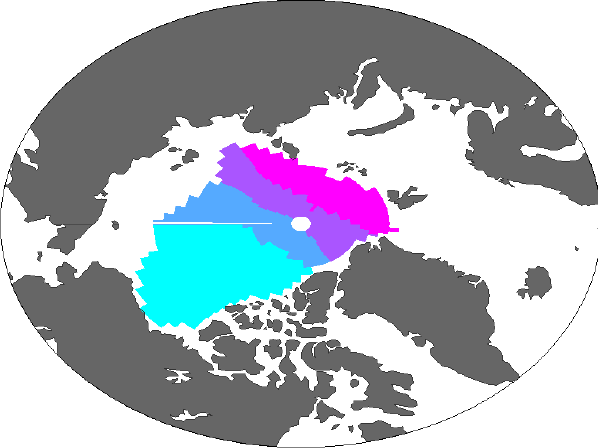
Figure 2. Map of the Arctic Ocean with the four basins’ definitions used to calculate averages shown in different